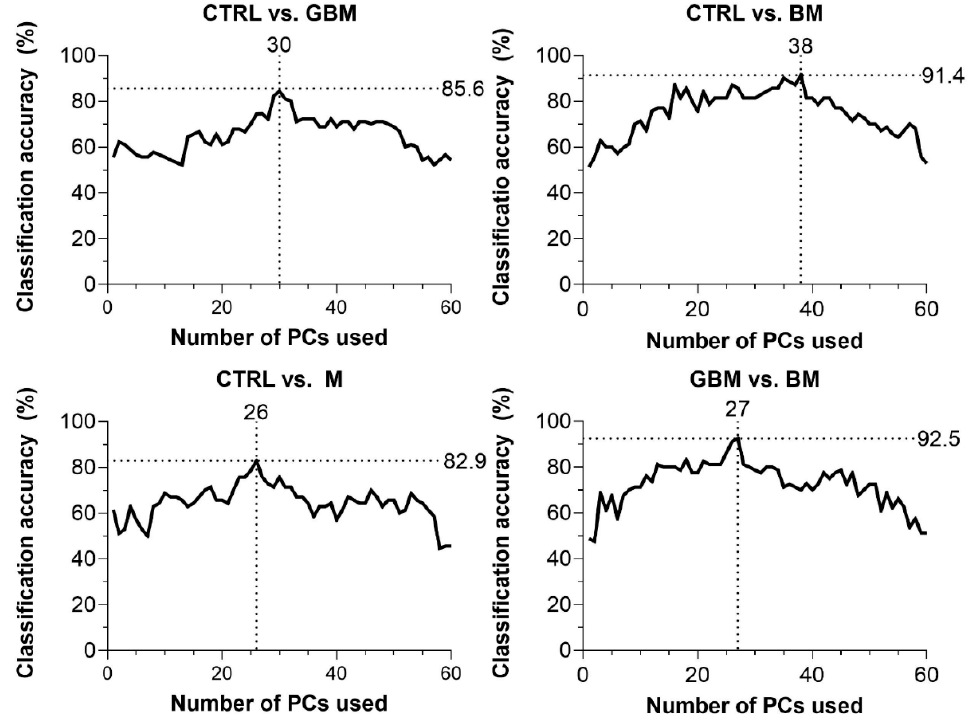
Figure 4. Classification accuracy (CA) scores with respect to the number of PCs included in the model (60 PCs at a maximum). Black dotted lines show the highest CA peaks with the corresponding number of PCs. (Abbreviations: PC, principal component).